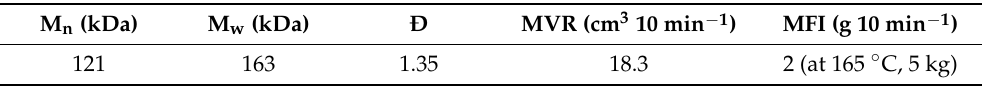
Table 1. Molecular weight (number-average and weight-average, polydispersity, melt volume rate, and melt flow index of PHBH (data taken from Reference